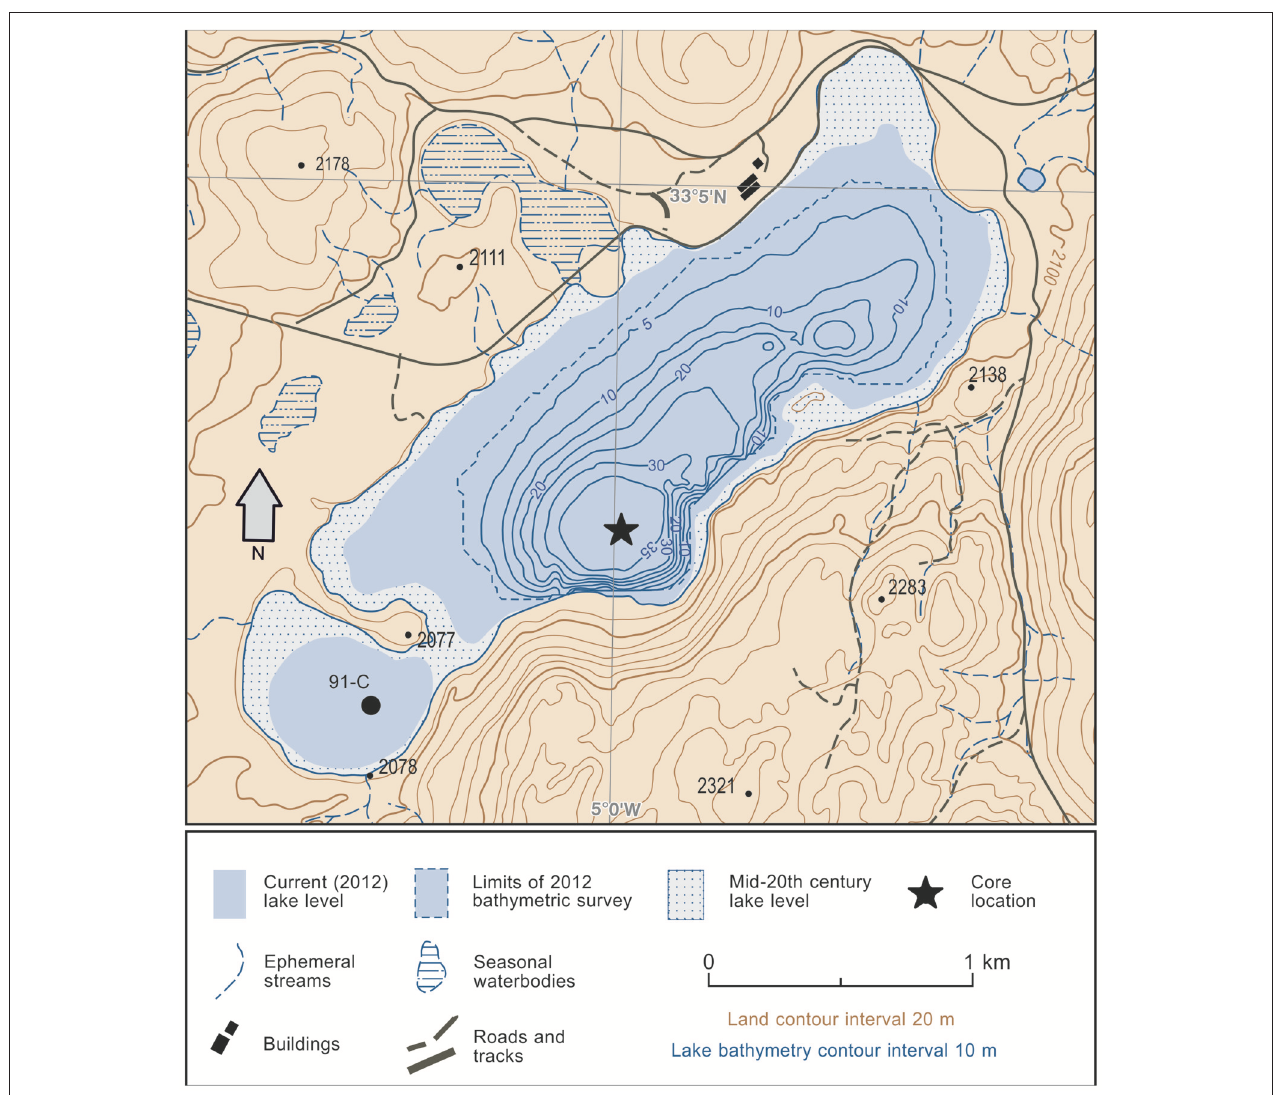
FIGURE 2 | Topographic setting and bathymetry of Lake Sidi Ali, showing the drilling position of core sequence ALI 01-10 (Zielhofer et al., 2017a and this study) and core 91-C ( Barker et al., 1994; Lamb et al.,